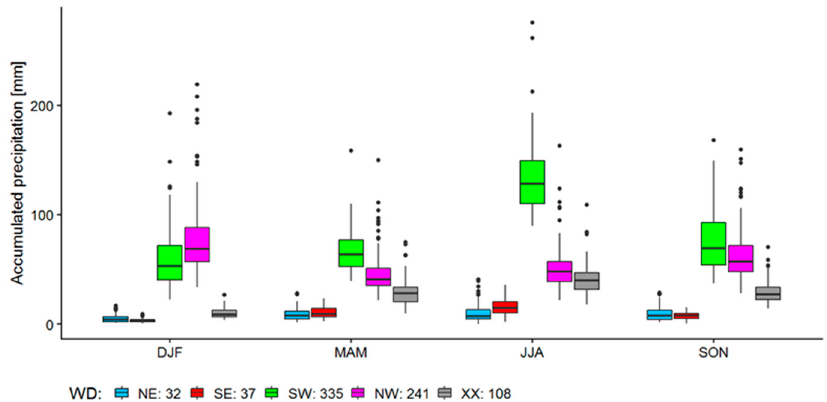
Figure 7. Boxplot of precipitation sums per wind direction (WD) in each season averaged over the measurement years for all stations. The numbers in the legend are the mean precipitation sums per year for each WD averaged over all stations in mm. For the WD classes, see Section 2.1. The representation of the boxplot is same as explained in Figure 5.